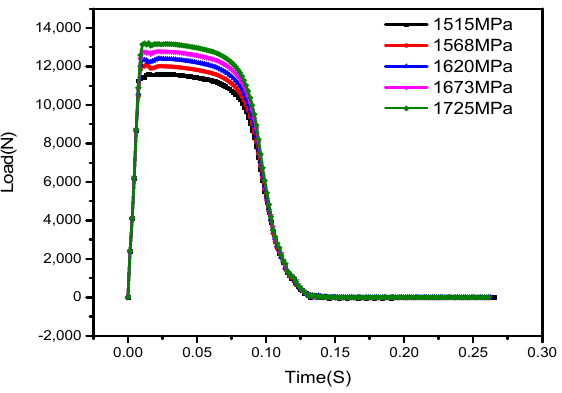
Figure 10. Tensile loads under different tensile strengths with a notch bottom diameter of 2.6 mm.